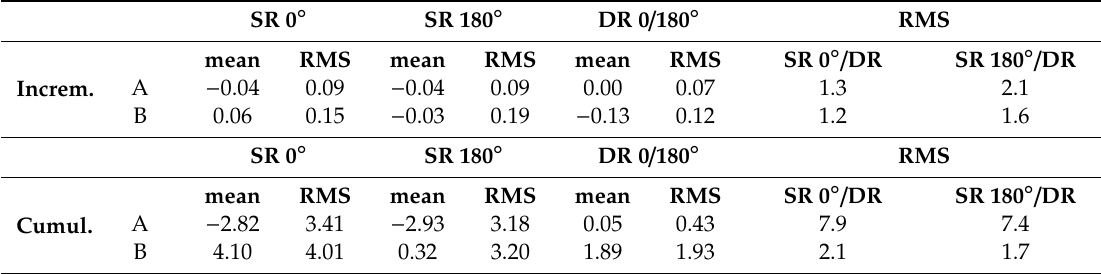
Table 5. Summary of the results obtained in Section 2 (55 measures). In the first part are the incremental displacements and in the second part are the cumulative displacements. SR 0 ◦ SR 180 ◦ DR 0 / 180 ◦ RMS mean RMS mean Increm. SR 0 ◦ SR 180 ◦ DR 0 / 180 ◦ RMS